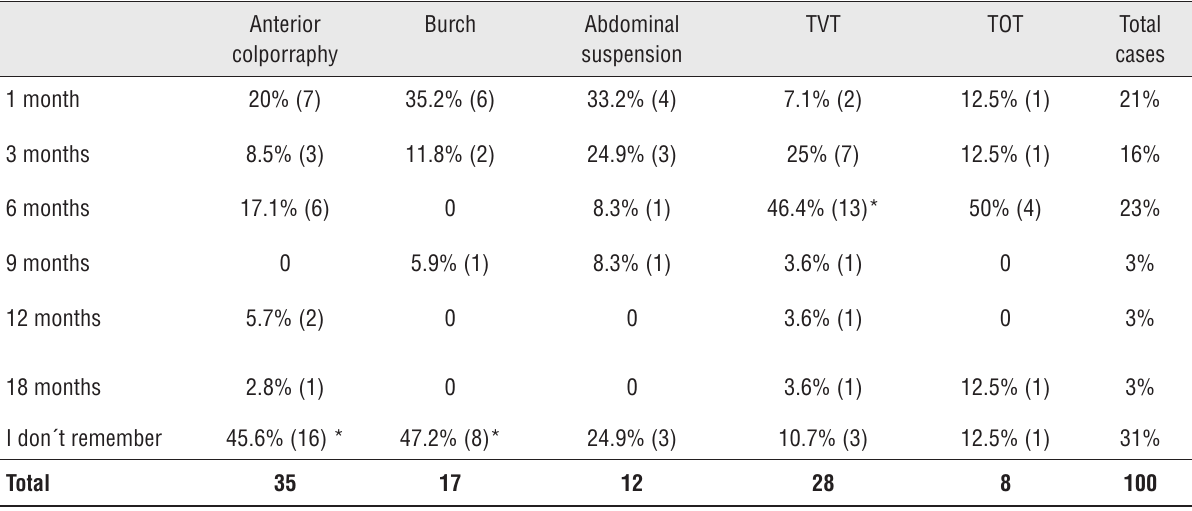
Table 2 – Time-frame of patient realizing failure of the operation.